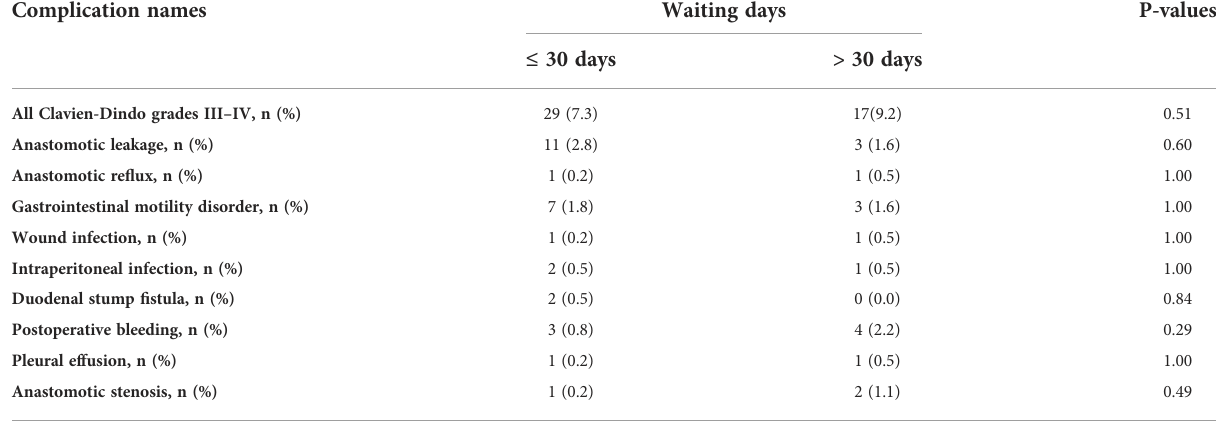
TABLE 5 A comparison of the complications of cases with grades III – IV between the delayed and short waiting groups.